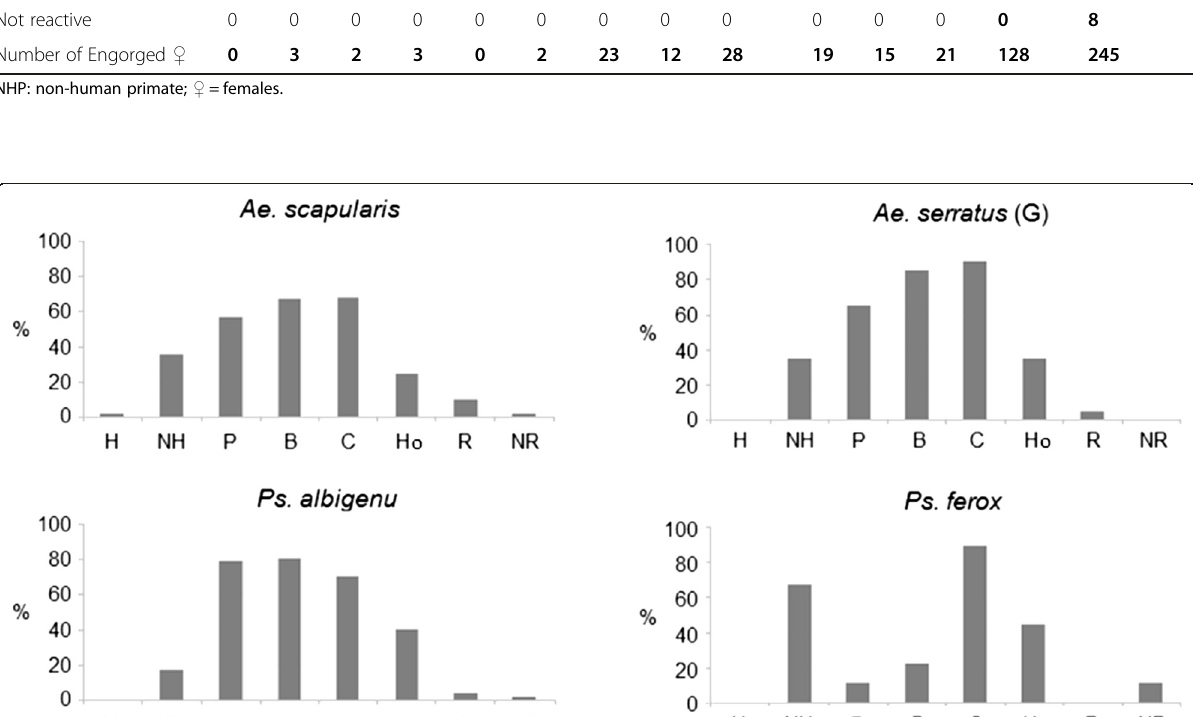
Horse Not reactive Number of Engorged ♀ Blood source